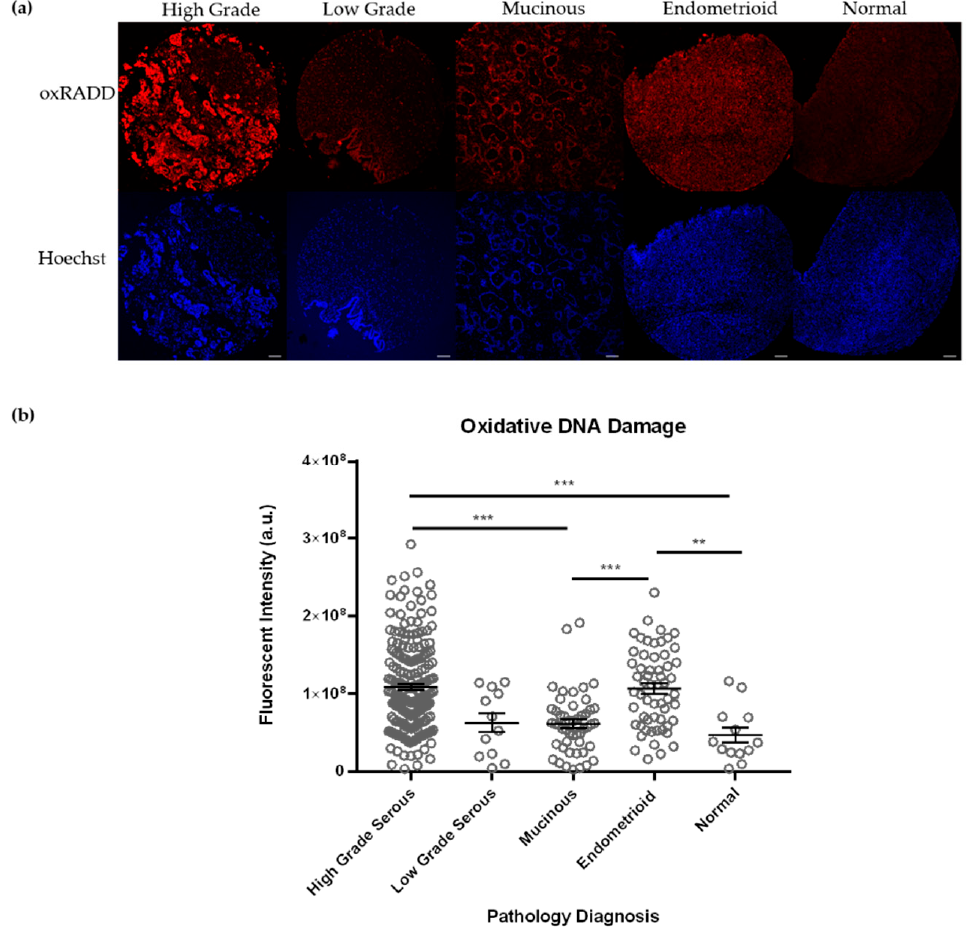
Figure 2. Oxidative DNA damage levels across pathological subtypes. ( a ) Representative images of tumor cores from each pathological subtype. Scale bar = 100 µ m. ( b ) Quantification of the oxidative DNA damage levels (oxRADD) within the major pathological subtypes contained on the TMAs. Full data can be found in Supplemental Information. *** p < 0.001 and ** p < 0.01.